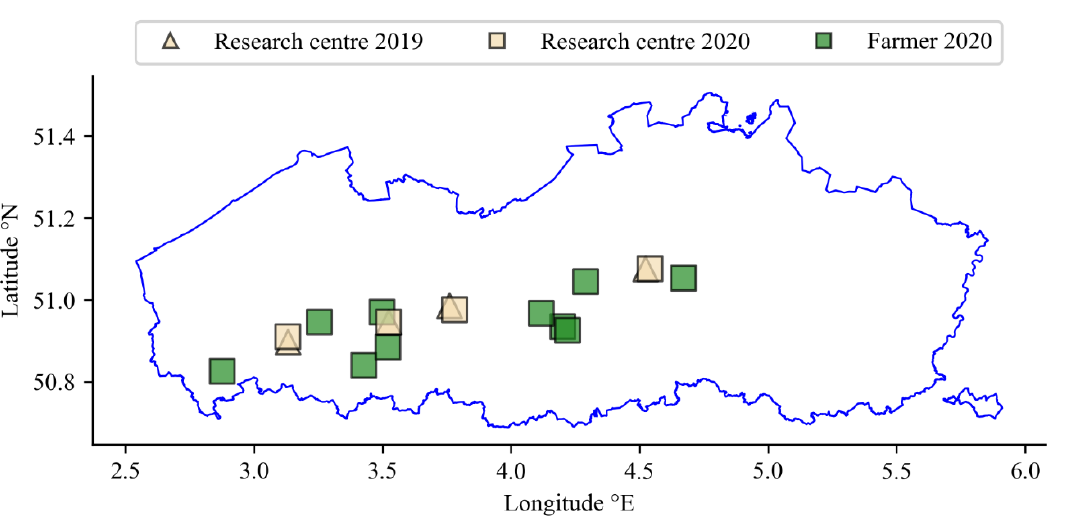
Figure 1. The location of the leek fields at the research centres (yellow) and farmers (green) during the 2019 (triangles) and 2020 (squares) experiments. Table 1. Description of the fields that were monitored during the experiments, the varieties that were planted, fertilizers used, the number of observations and flights for both the plant nitrogen uptake (N-uptake) and dry biomass (DBM) and the days after planting (DAP) on which the flights were